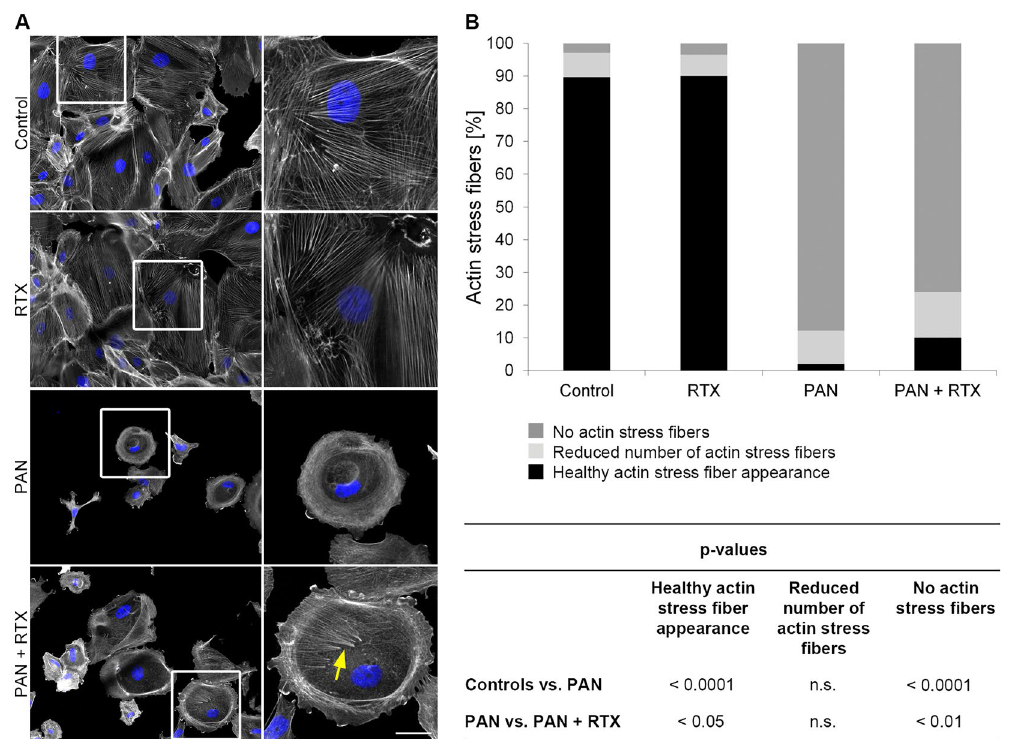
Figure 2. Rituximab prevents disruption of the actin cytoskeleton in human podocytes. ( A ) Actin (phalloidin- TRITC, grey) and nuclear staining (DAPI, blue) of human podocytes. Scale bar = 50 µm. ( B ) Number of central actin stress fibers [%]. For classification podocytes were divided into three groups: "healthy actin stress fiber appearance", "reduced number of actin stress fibers" and "no actin stress fibers". Statistics: One-way ANOVA with Tukey’s multiple comparisons test; the mean ± SD is shown [%]. n = 4 experiments; ≥ 25 images per condition. n. s. = not significant. RTX = rituximab (100 µg/ml); PAN = puromycin aminonucleoside (30 µg/ml). Treatment time: 48